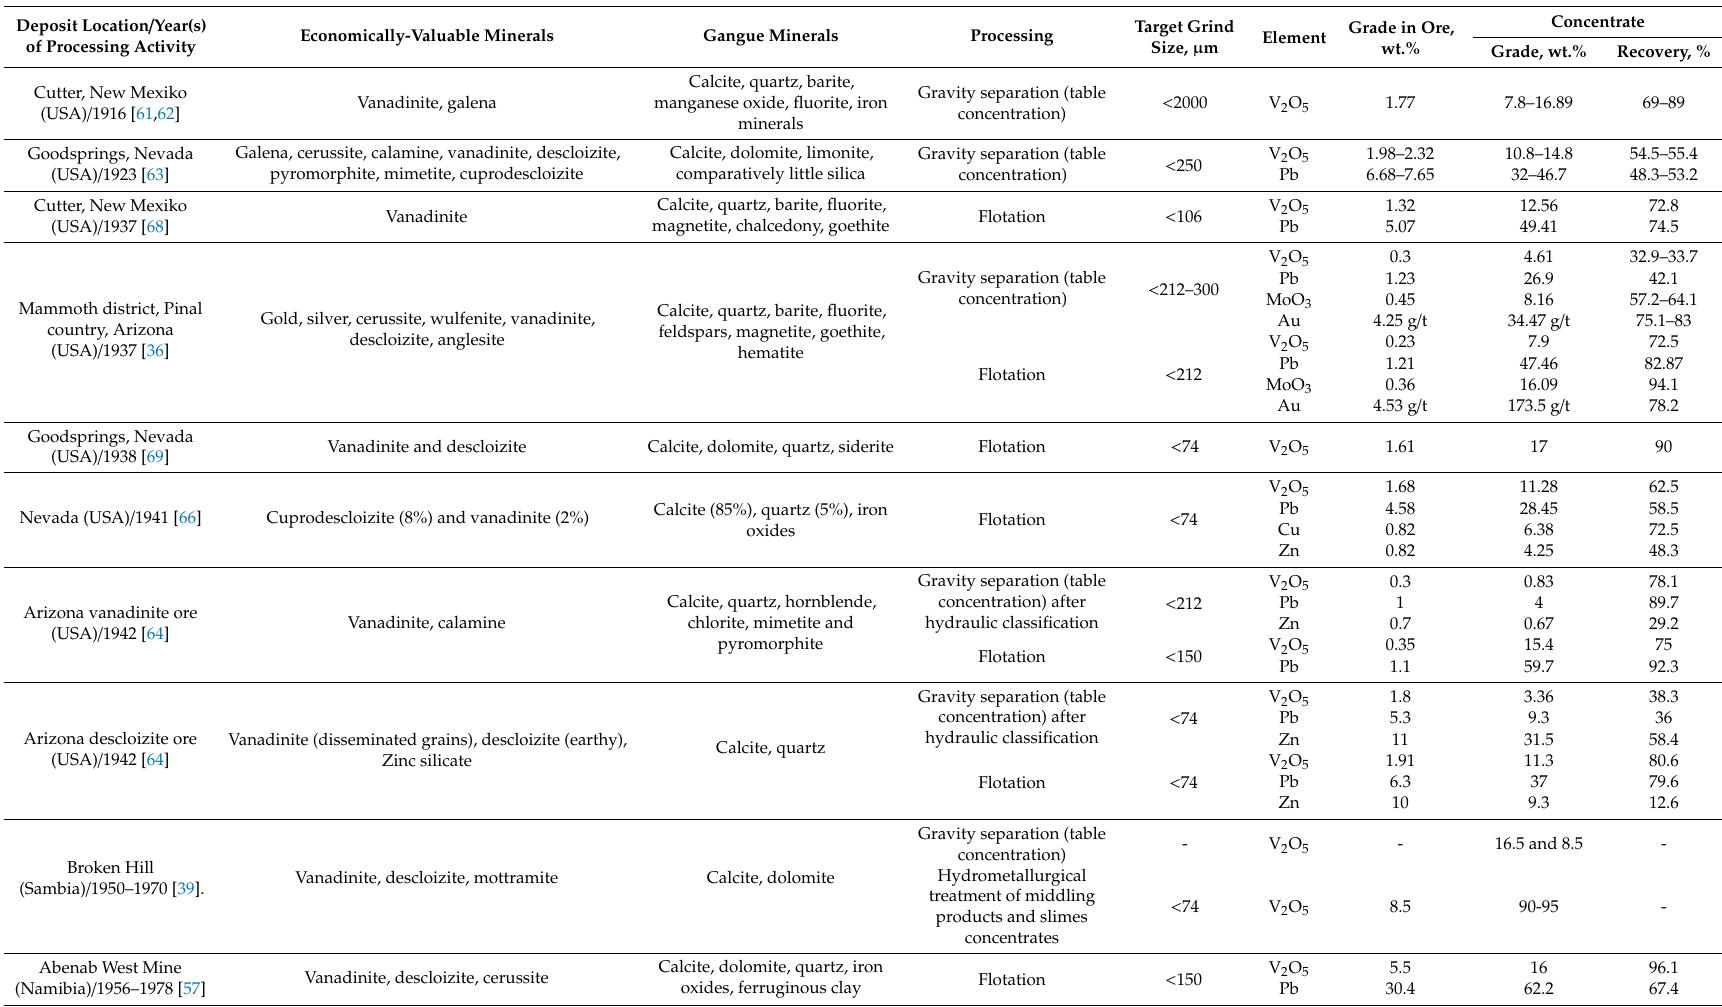
Table 4. The summary information and metallurgical results of various lead vanadate